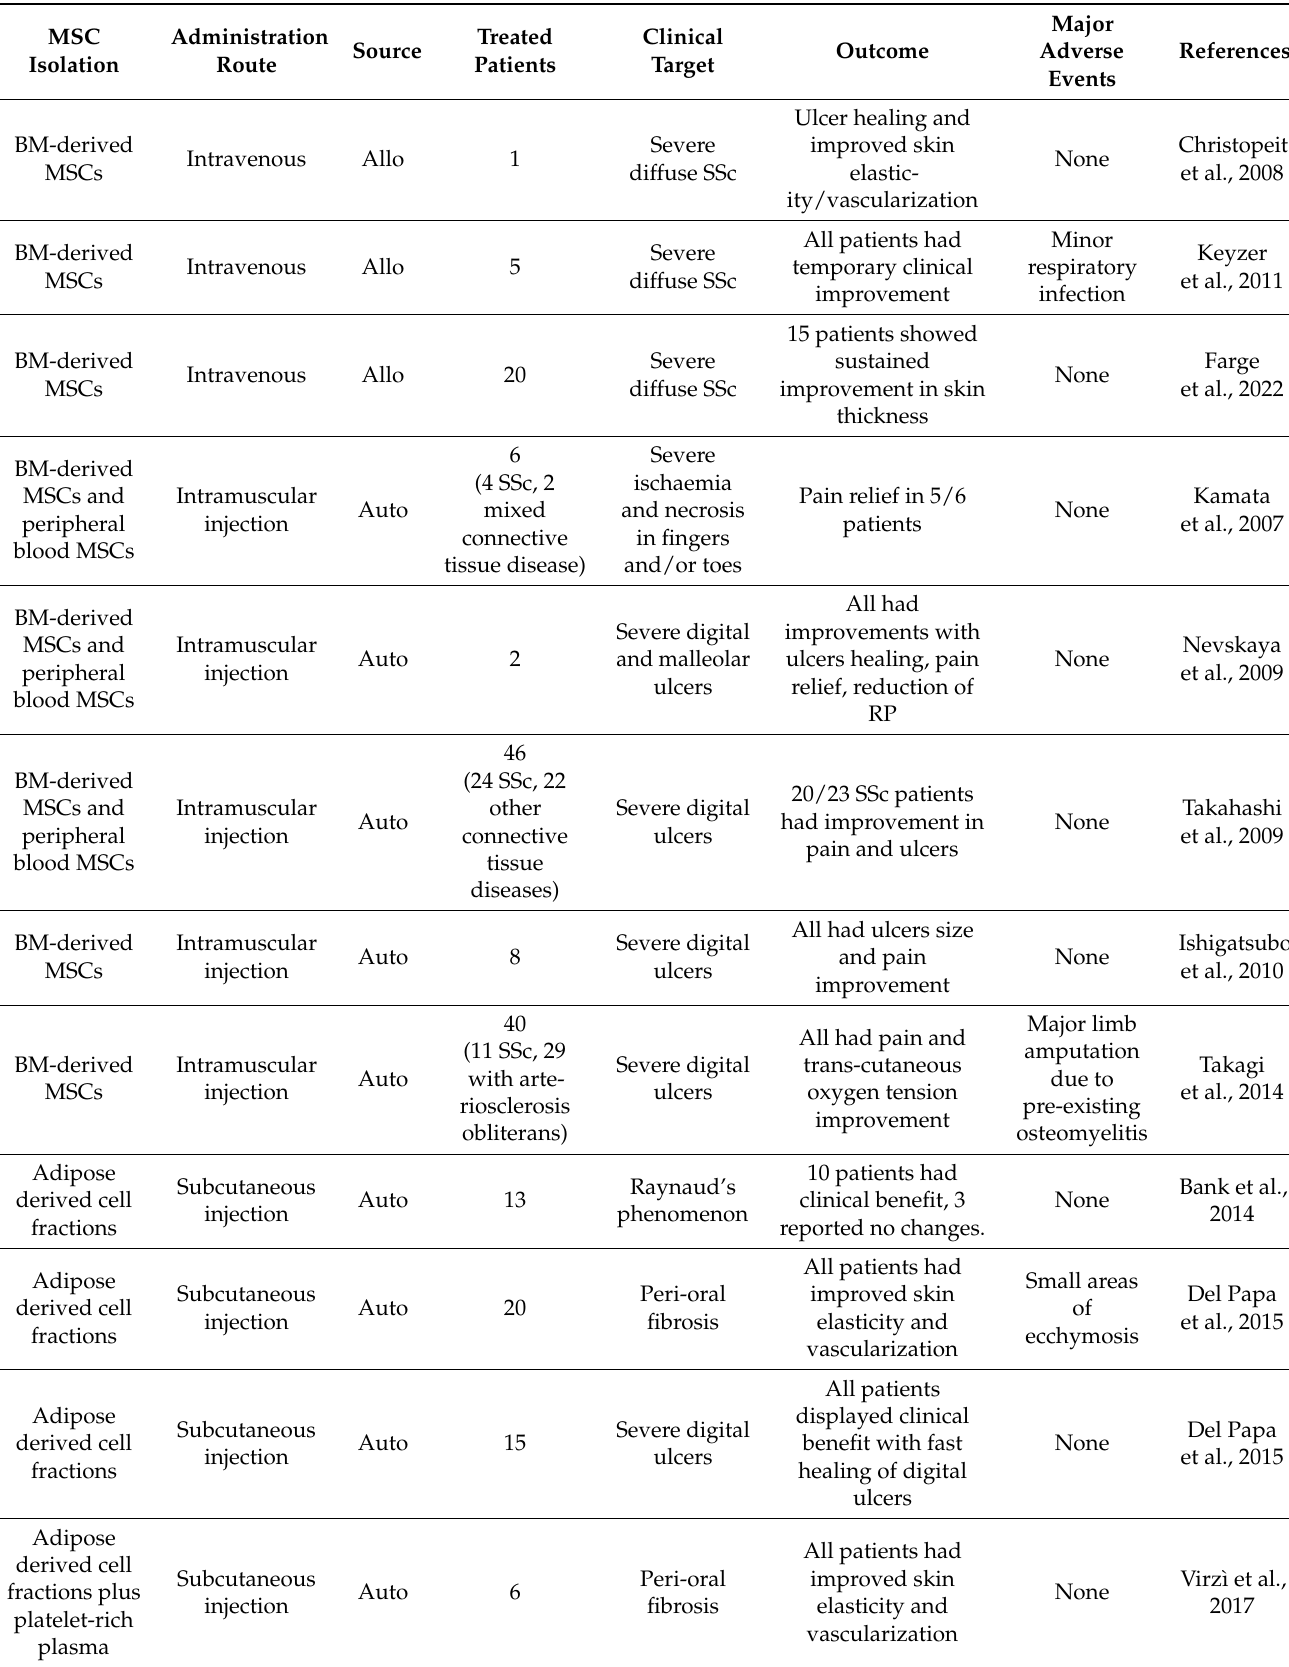
Table 1. Clinical trials investigating mesenchymal cells for the treatment of systemic